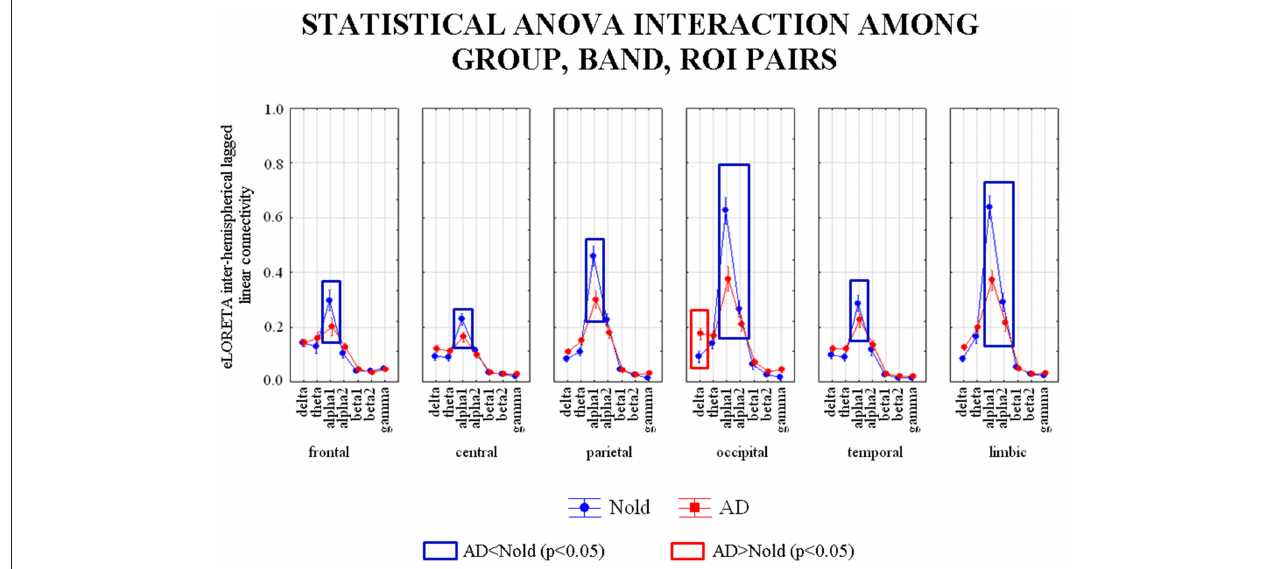
FIGURE 3 | Diagram showing the grand average of the EEG inter-hemispherical lagged linear connectivity computed between left and right hemispheres in the six regions of interest (ROI). These values refer a statistically significant ANOVA interaction [ F (30 , 6540) = 4.8771 , p < 0.0001] among the factors Group (Nold, and MCI), Band (delta, theta, alpha 1, alpha 2, beta 1, beta 2, gamma), and ROI pairs (frontal left-frontal right, central left-central right, parietal left-parietal right, occipital left-occipital right, temporal left-temporal right, and limbic left-limbic right). Subjects’ age, education, IAF, and gender were used as covariates. Legend: the rectangles indicate the ROIs and frequency bands in which connectivity values presented the pattern Nold 6= AD (Duncan test, p < 0.05).